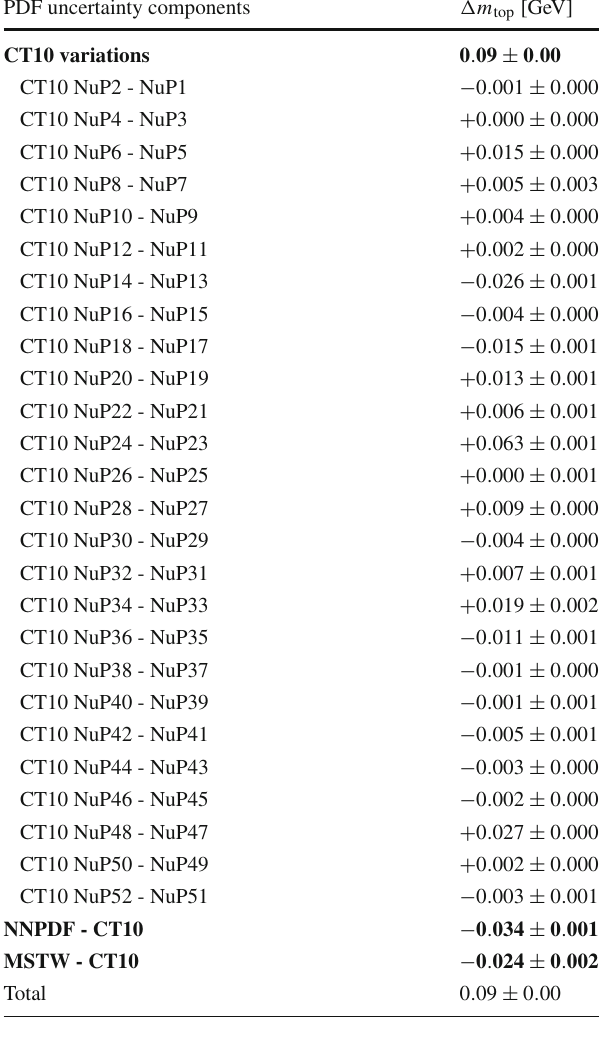
Table 9 The individual components of the PDF uncertainty consid- √ s = 8 TeV, the resulting ered for the t ¯ t → lepton + jets analysis at PDF-uncertainty-inducedshiftsin m top andthefinaluncertaintyin m top . The components [31,39,42] together with their statistical precisions are listed in boldface. The total uncertainty in the CT10 variations is calcu- lated as the sum in quadrature of the CT10 subcomponents. The total uncertainty is given with 0.01 GeV precision. Uncertainties quoted as 0.00 (0.000) are smallerthan 0.005 (0.0005). The term nuisance param- eter is denoted by NuP . The last line refers to the sum in quadrature of the PDF